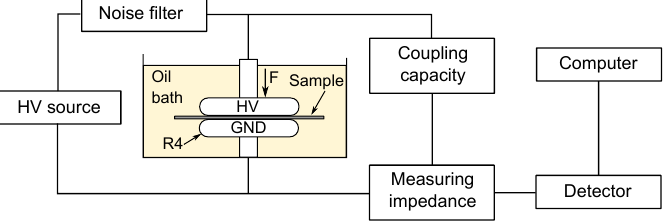
Figure 11. Partial discharges measurement circuit according to IEC 60270